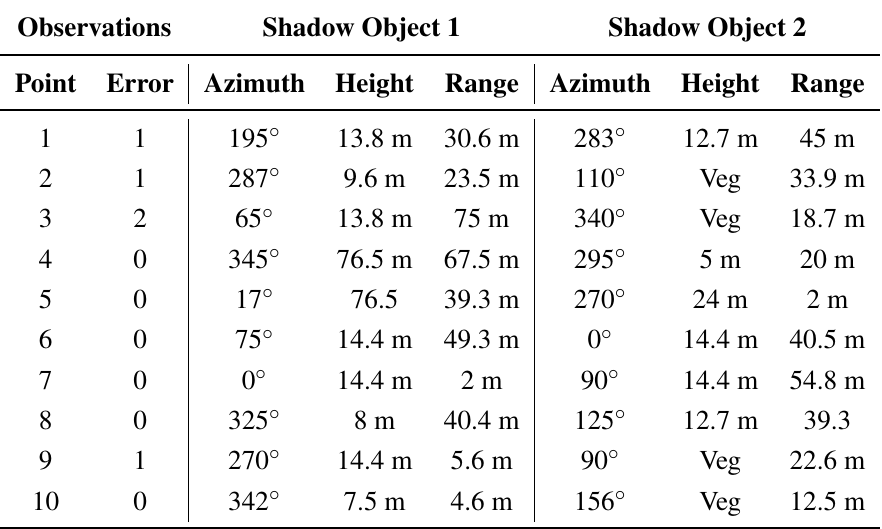
Table 3. Details of the two predominant shadowing objects at each GNSS validation